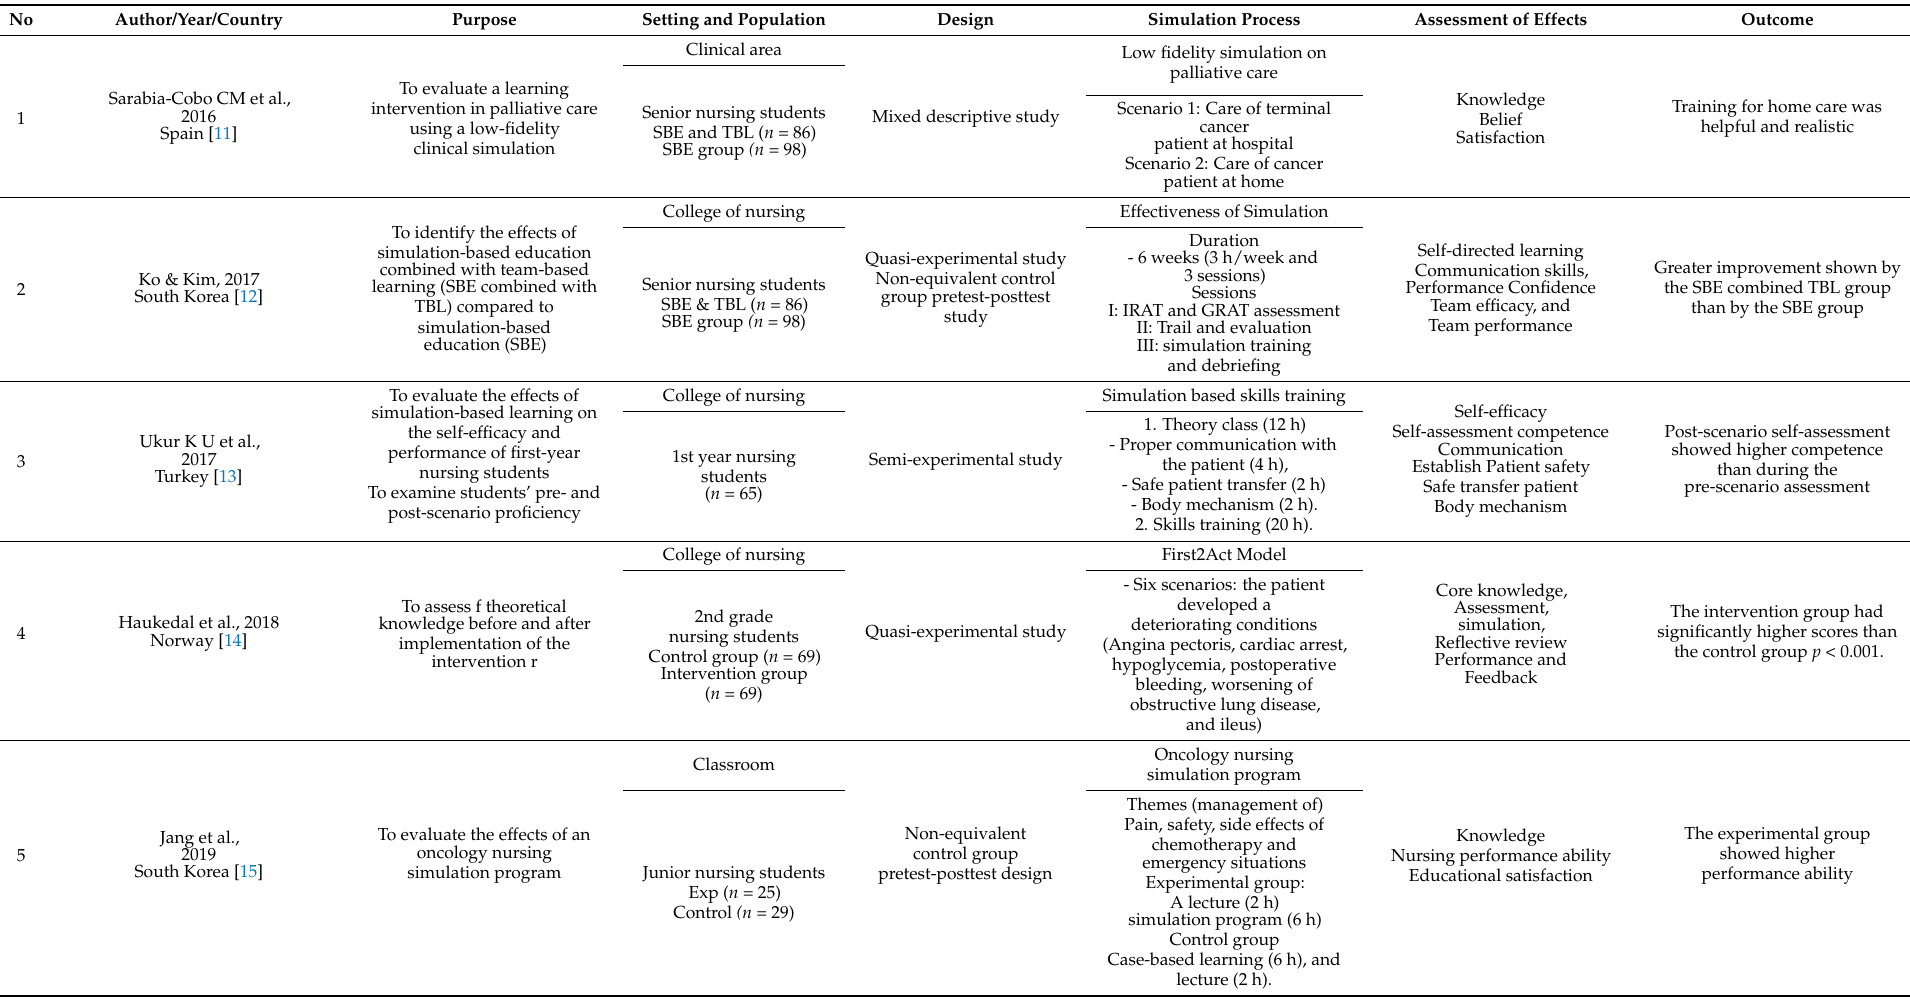
Table 1. Description of the articles included for